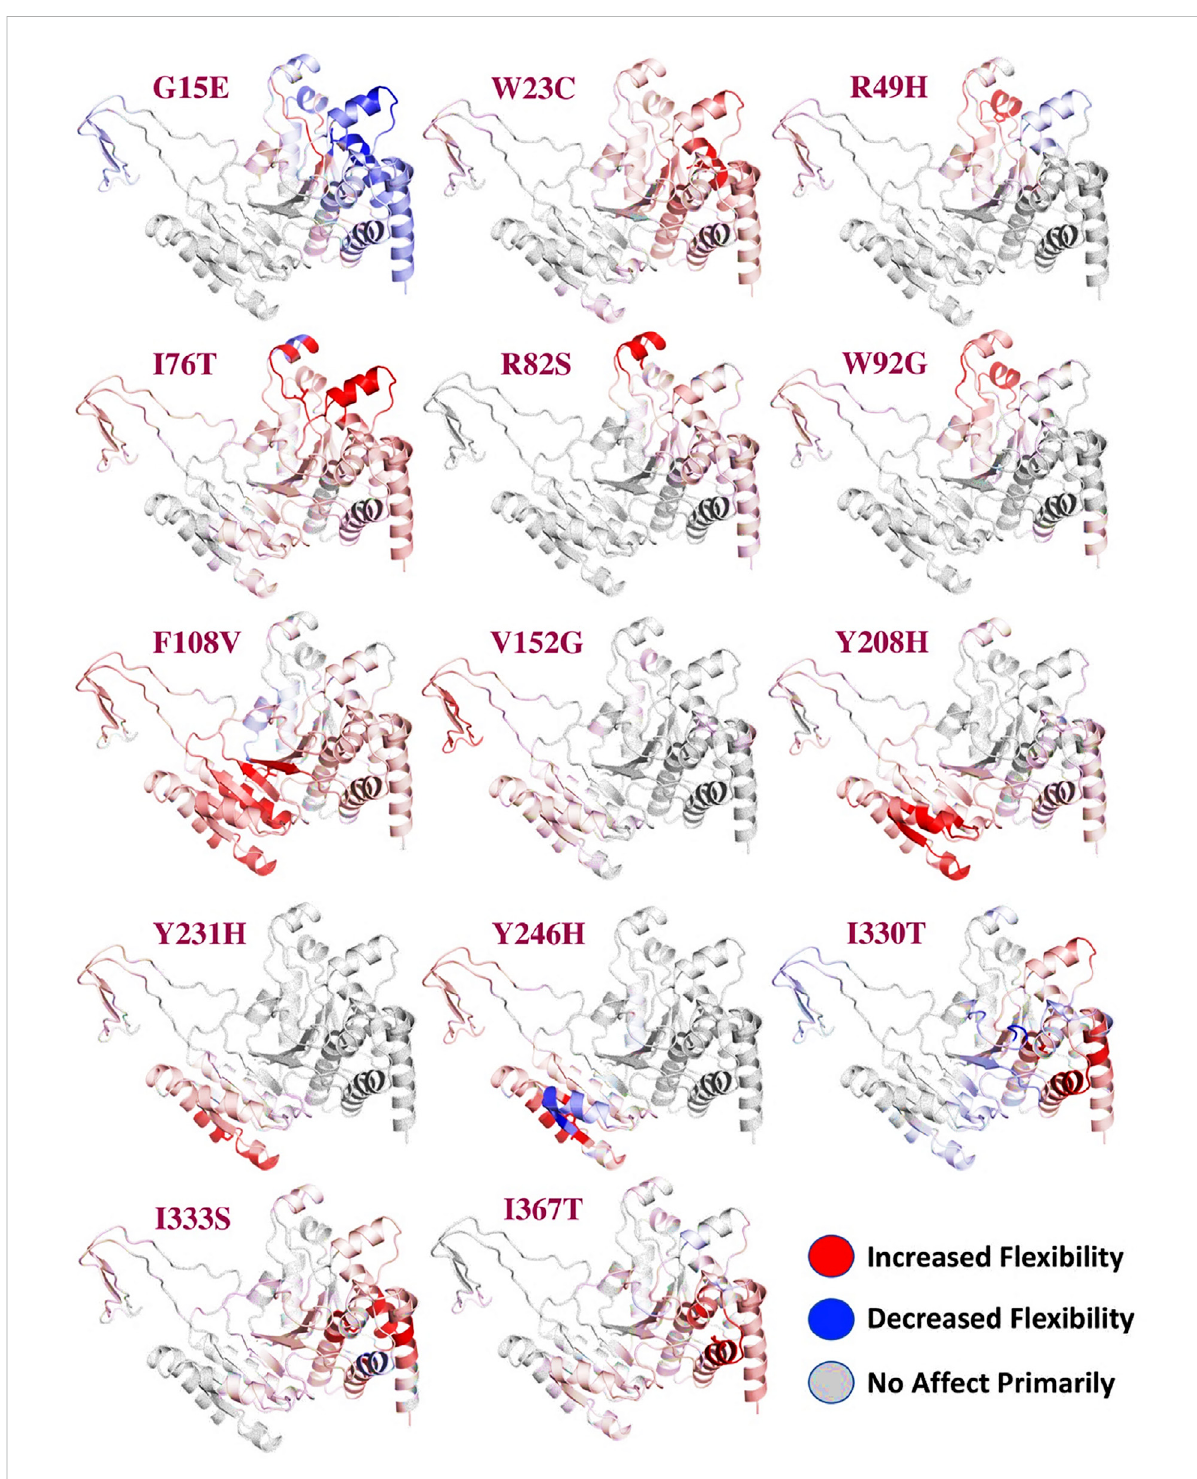
FIGURE 2 Effect of mutations on the fl exibility of different residues. Different colors represent different levels of fl exibility. The red regions demonstrate that the fl exibility is increased, the blue regions show that the fl exibility is decreased due to the mutations, and gray represents no change in the fl